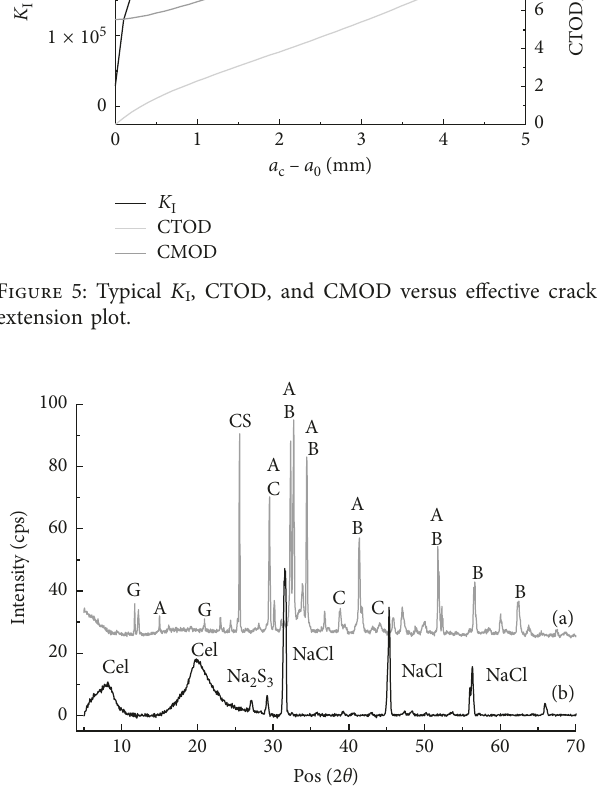
Figure 6: X-Ray diffraction pattern of (a) cement and (b) VMA 2H 2 O); CS: anhydrite (CaSO 4 ); (Cel: cellulose; G: gypsum (CaSO 4 · A; alite; (B) belite; C: calcite; cps: counts per second).